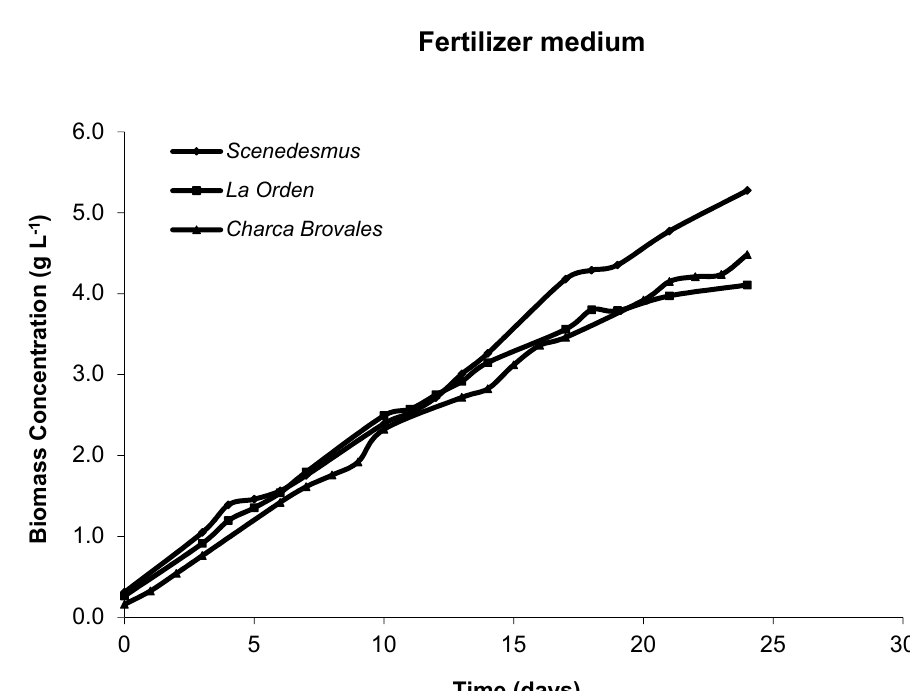
Figure 5. Growth curves of the different microalgae populations cultured in Arnon medium.